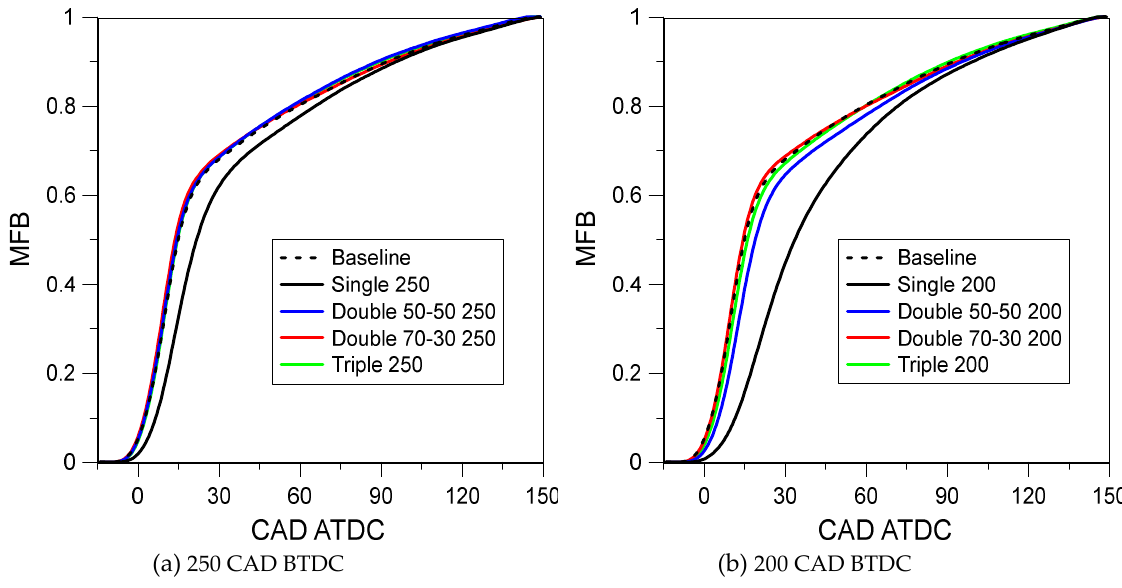
F igure 6. Mass fraction burned for different split injection strategies at fixed SA (15 CAD BTDC) and engine speed (2000 rpm); second injection phasing set at 250 ( a ) and 200 ( b ) CAD